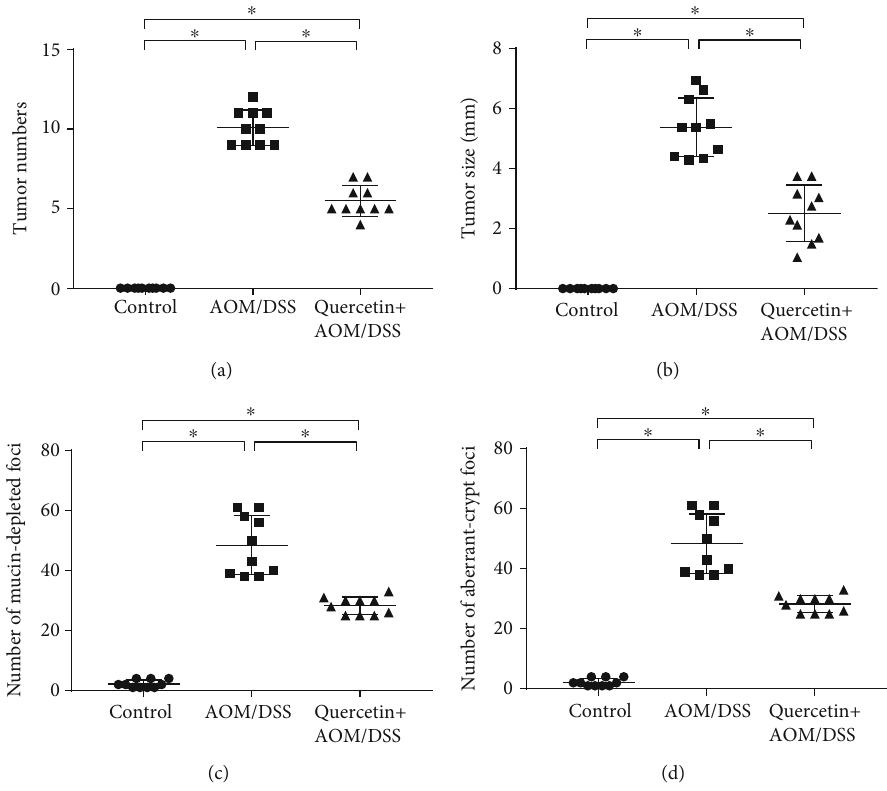
Figure 2: Quercetin reduces tumor incidence in AOM/DSS-treated mice. (a) Number of colon tumors in the control ( n = 10 ), AOM/DSS- treated ( n = 10 ), and quercetin+AOM/DSS cotreated ( n = 10 ) groups. (b) Size of colon tumors in the control ( n = 10 ), AOM/DSS-treated ( n = 10 ), and quercetin+AOM/DSS cotreated ( n = 10 ) groups. (c) Quanti fi cation of mucin-depleted foci in control and experimental mice. (d) Quanti fi cation of aberrant crypt foci in control and experimental mice. Data are expressed as mean values ± SD ( n = 10 /group). ∗ P < 0 : 05 , Student ’ s t